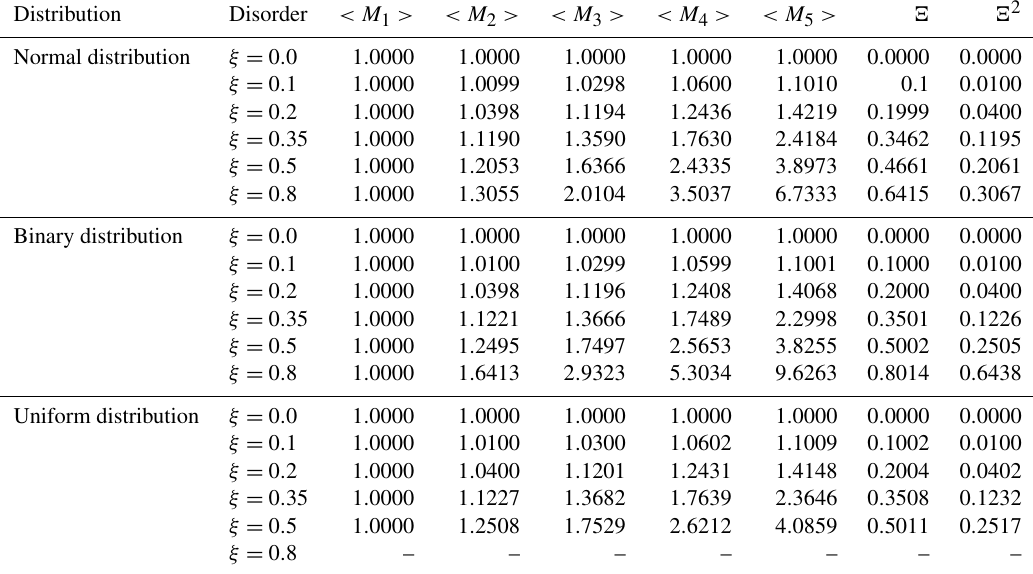
Table 1. Scaled moments of ensemble-averaged distributions (500 ensembles) used for the one-dimensional chain (256 elements long). Distribution